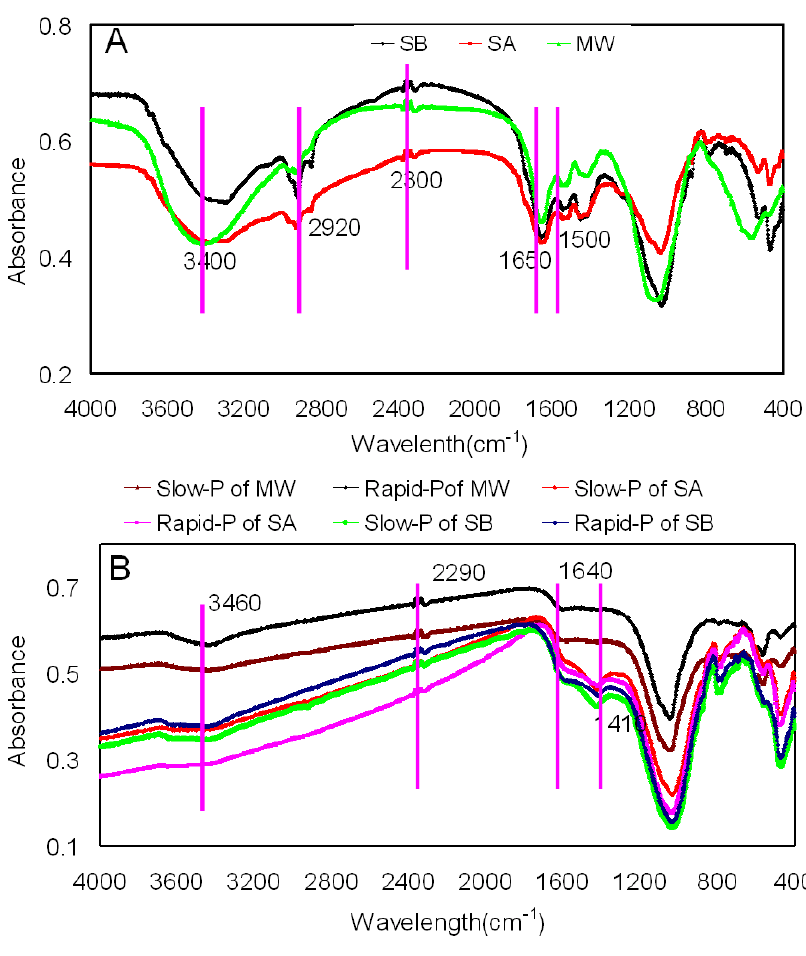
Figure 4. FTIR spectra of biomass and char: A is for three kinds of biomass; B is for char obtained after the rapid and slow pyrolysis at 700